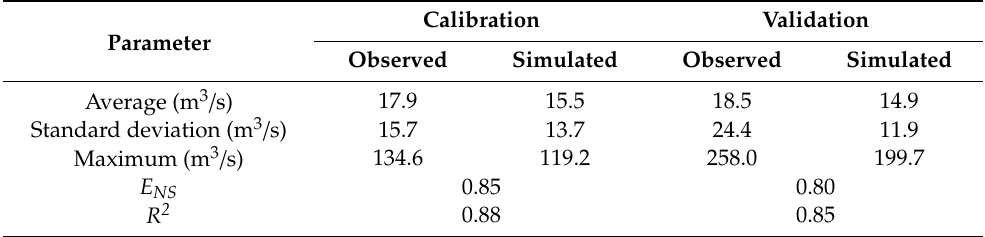
Figure 6. Observed and simulated average river flow: ( a ) daily data, ( b )monthly data. Table 2. Statistical indexes, E NS , and R 2 of the observed and simulated series for model calibration and validation.